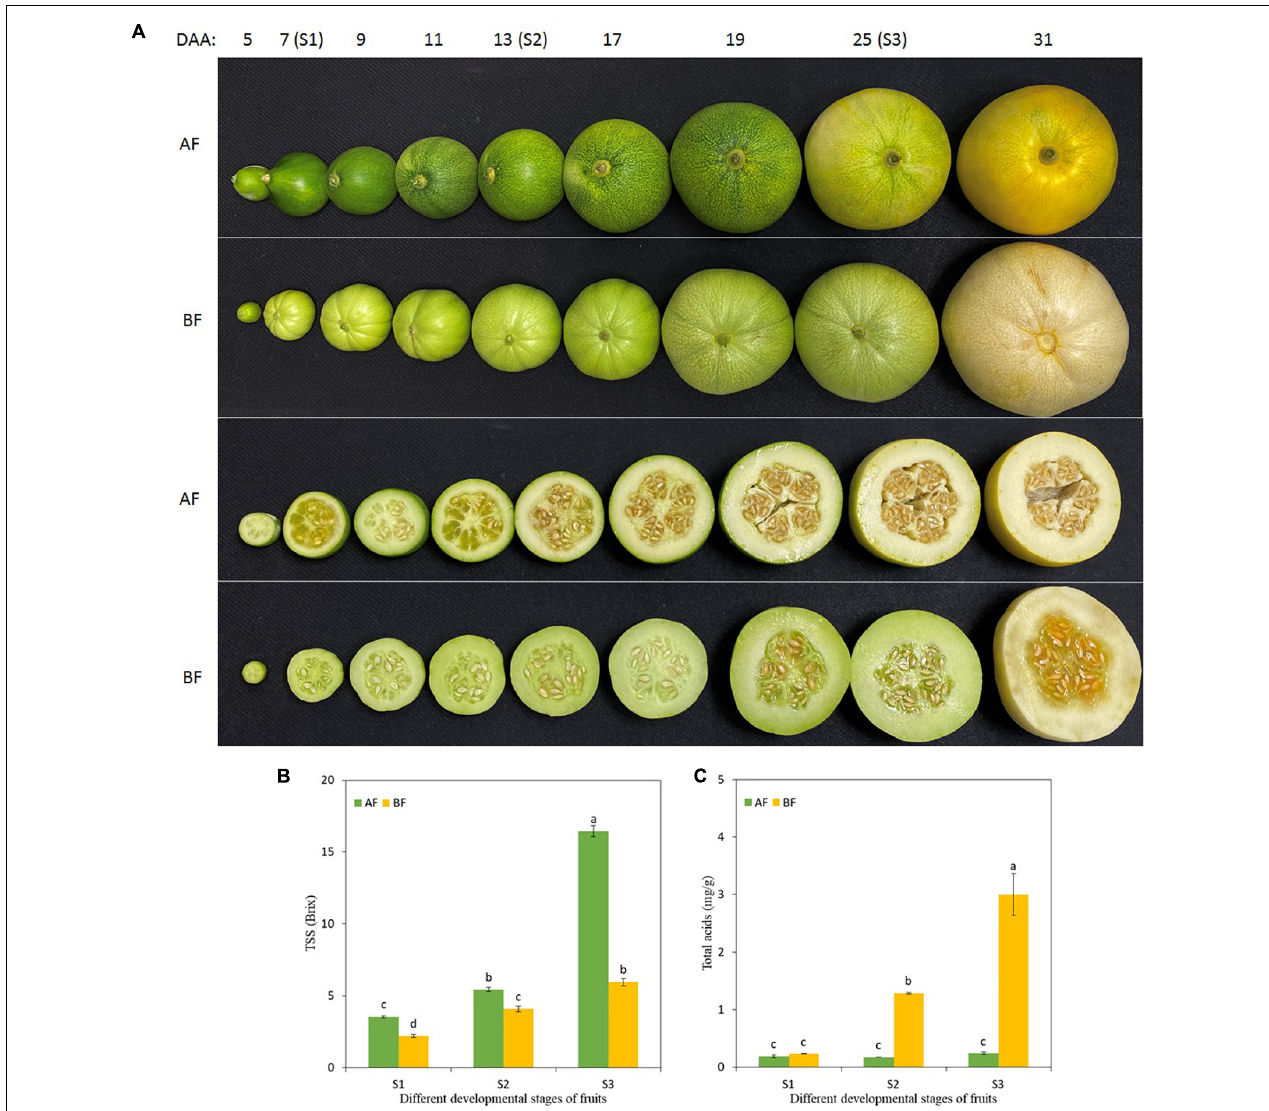
FIGURE 1 | Changes in oriental melon fruits during consecutive ripening stages. (A) Pictures of oriental melon cultivars A and B fruits at different developmental stages, and the collection stages of fruit samples were S1 (7 DAA), S2 (13 DAA), and S3 (25 DAA). (B) TSS in the fruit during the three ripening stages. (C) Total acids in the fruit during the three ripening stages. Values are means ± standard errors (SE) ( n = 3) and bars indicate SE. Significant differences between columns are indicated by different letters (Duncan’s test, p <